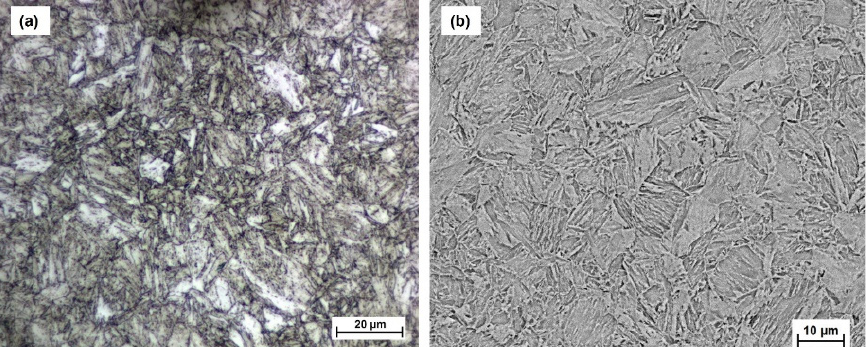
Figure 1. S960QL base material microstructure. ( a ) Optical micrograph; ( b ) SEM micrograph, M = 1000× (2% Nital).